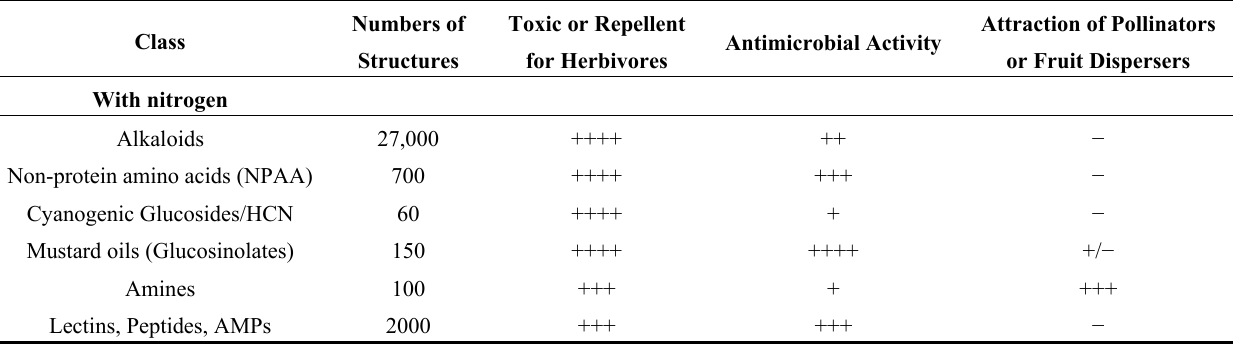
Table 3. Estimated number of described secondary metabolites and their main functions for the plants producing them * (after